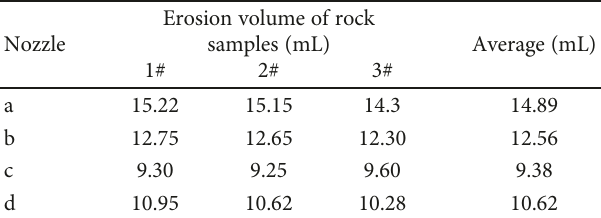
Table 9: Erosion volume of di ff erent nozzle. Erosion volume of rock Nozzle